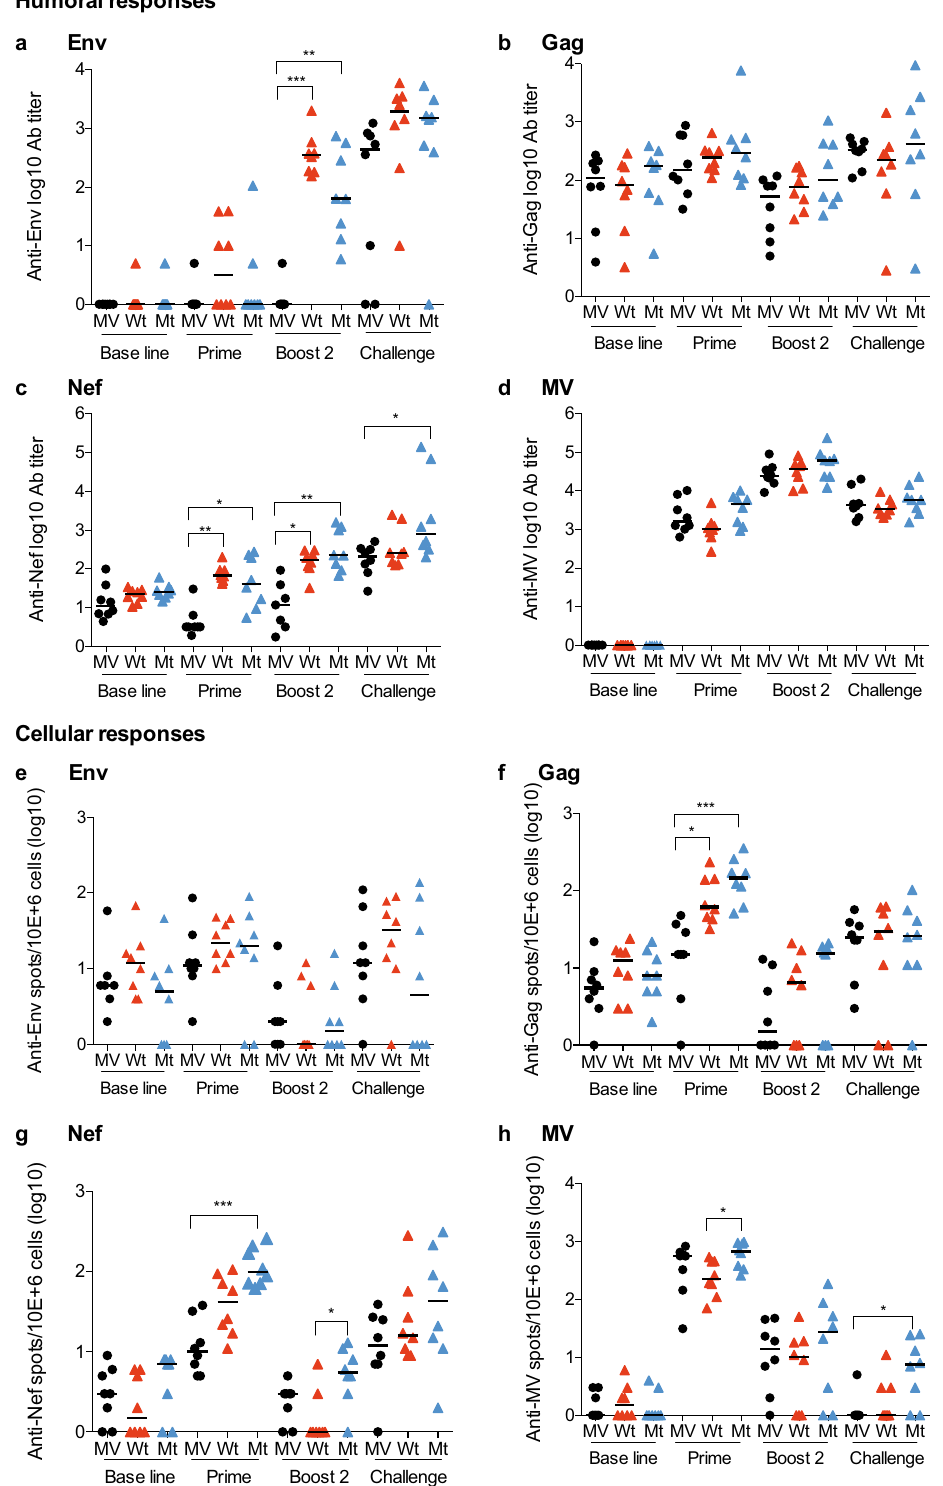
Fig. 4 Vaccine-elicited humoral and cellular immune responses. a – d IgG antibody titers (log-endpoint ELISA titration) against ( a ) Env (gp120), b Gag, c Nef, d MV proteins. e – h FluoroSpot assays, IFN- γ -producing cells speci fi c to ( e ) Env, f Gag, g Nef, and ( h ) MV proteins. P values are calculated by the Kruskal – Wallis and Dunn ’ s multiple comparisons tests. P values: NS > 0.05, *< 0.05, **< 0.01, ***< 0.001. Group medians are plotted as a horizontal line. Serum or PBMC was collected at the baseline (week − 2), prime (week + 2), boost 2 (2 weeks post boost 2: week + 31), and post challenge (2 weeks post fi rst positive qRT-PCR for SHIV162p3 RNA in